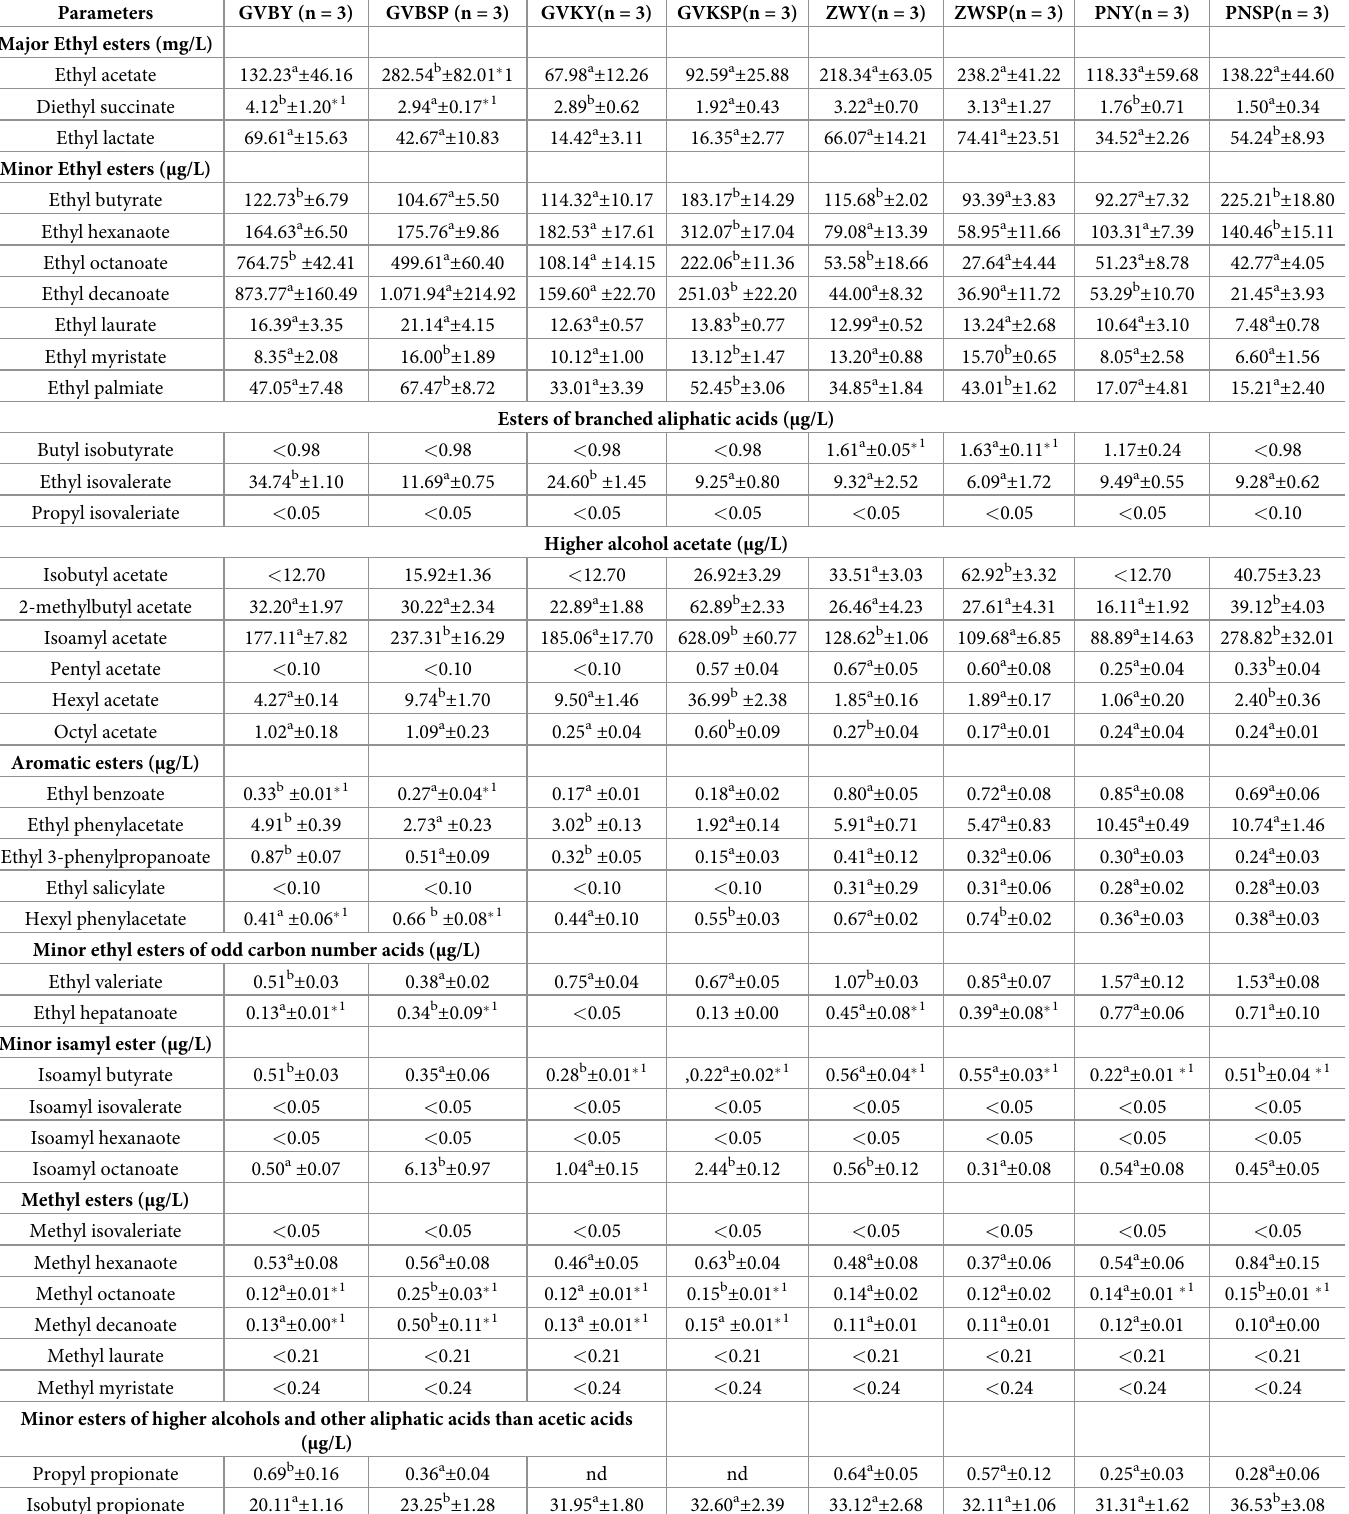
Table 3. Content of ester compounds in the